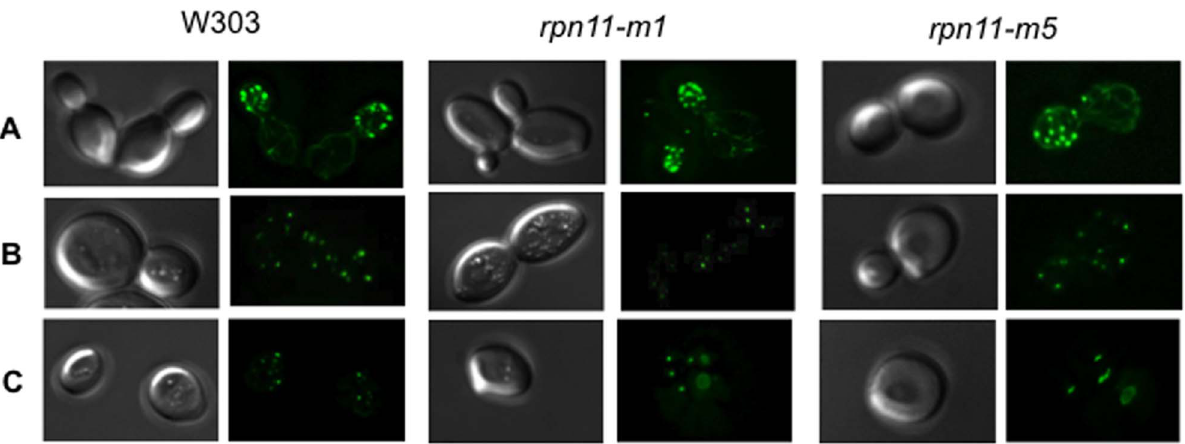
Figure 5. Actin cytoskeleton organization upon entry into the stationary phase. Wild type, rpn11-m1 and rpn11-m5 cells were grown in YPDA medium at 26 u C. At various stage ( A ) exponential phase, ( B ) diauxic shift and ( C ) after five days in stationary phase, cells were taken off and stained with Alexa-phalloidin.